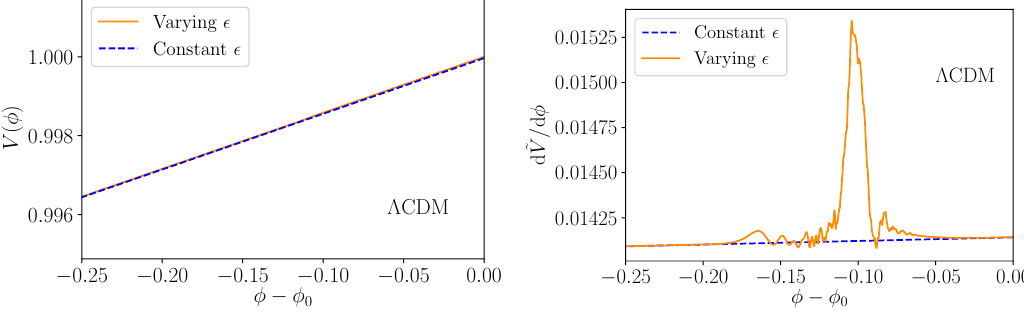
Figure 6: The right panel shows the 2nd-order reconstructed ε for the ∆ estimated from Planck data assuming Λ CDM (left panel, dashed blue line). The blue (full covariance matrix) and green (its diagonal approximation) shaded bands indicate the 1 σ uncertainties in ε due to errors in the estimated PPS. The orange line in the left panel is the PPS obtained by numerical integration of the reconstructed ε .